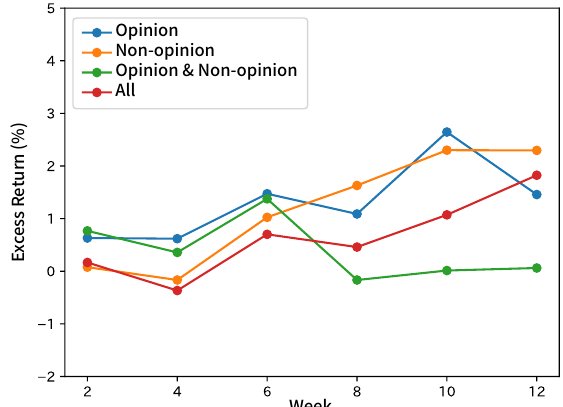
Figure 9. Excess returns of Broker A in forecasting excess returns.